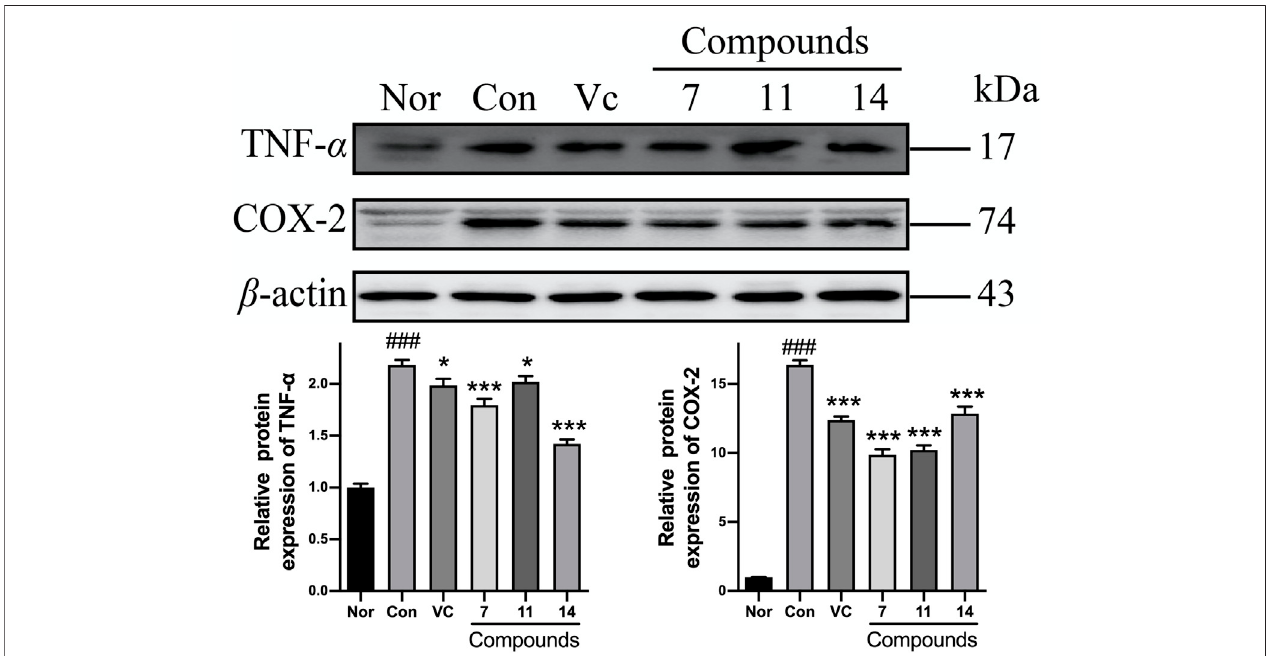
FIGURE11| Thein fl uenceofcompounds 7 , 11 ,and 14 atconcentrationof50 μ Montheproteinofin fl ammatorycytokines(TNF- α andCOX-2)inHaCaTcells.Nor: normal group; Con: UVB-induced group; Vitamin C (Vc). Values represent the mean ± SEM of three determinations ( ### p < 0.001 vs. Nor; *** p < 0.001 and * p < 0.05 vs.